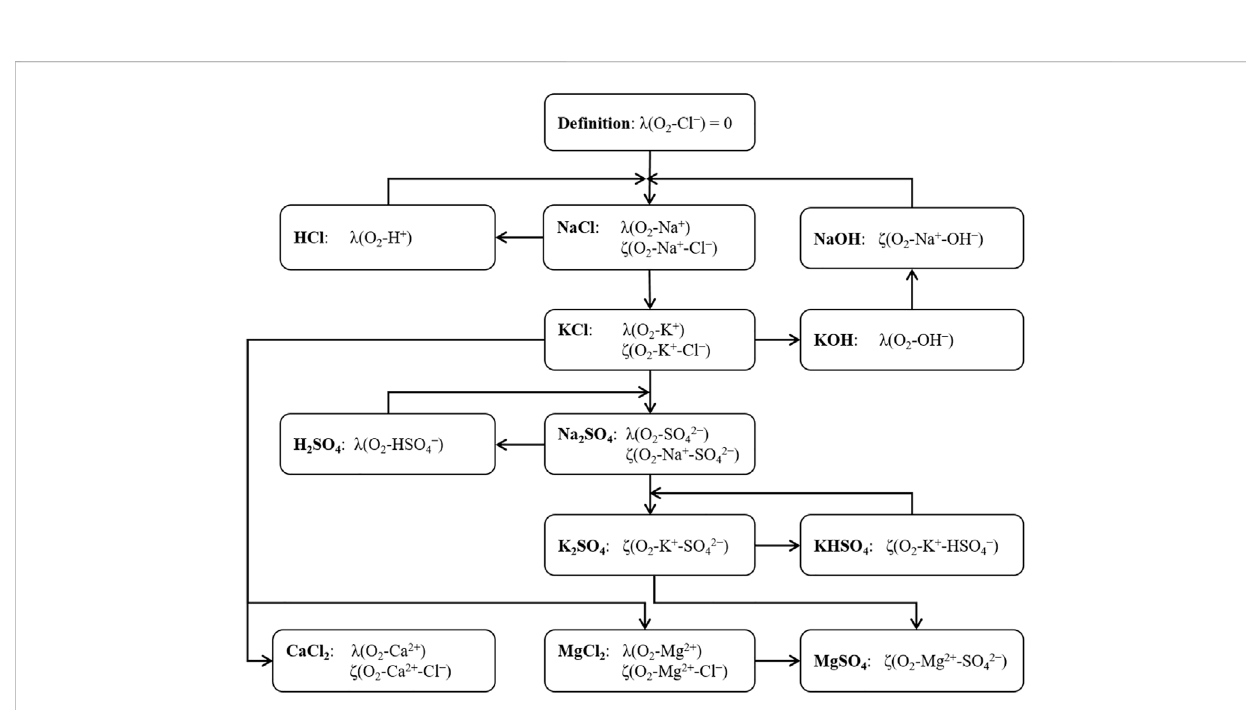
FIGURE 2 Fitting scheme for the generation of the Pitzer interaction coef fi cients temperature parameters.